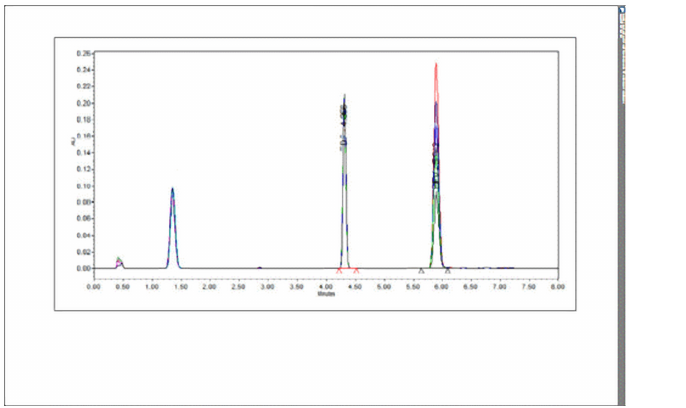
Fig 3. Chromatogram for linearity study.